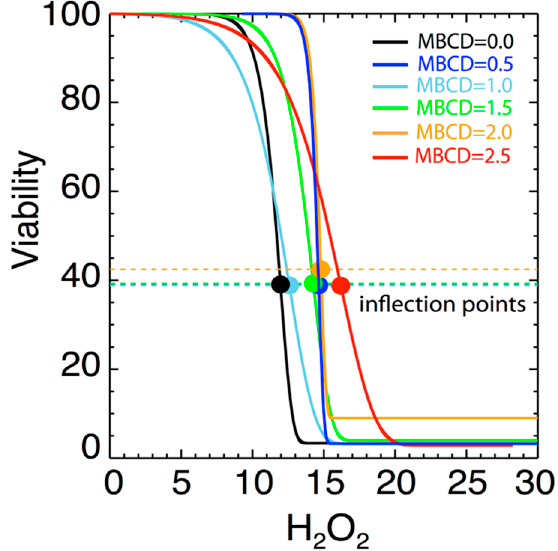
Figure 8. (Left) Diagrams of the modified p -value and reduced chi-square characterizing the linear fitting of the parameters α (a) , β (b) , γ (c) , and δ (d) , with MßCD plotted, as a function of the multiplication factor (M.F.). We identify the M.F. value, for which the corresponding p -value and reduced chi-square are optimized. The goodness of fit is shown using both the modified p -value and reduced chi-square. (Right) Here, the goodness of fit is shown using the unified measure as given by Equation (9) while it is depicted as a function of the signal-to-noise ratio of the slope b/ δ b , characterizing the linear fitting of the parameters with MßCD; (note: Both the ratio b/ δ b and the goodness of fitting are plotted as functions of the multiplication factor (M.F.)). The cases of the parameter α and γ have the optimal values of the p -value and reduced chi-square for │ b/ δ b │ < 1, so that the hypothesis of being dependent on MßCD is rejected. On the other hand, the cases of the parameter β and δ have the optimal values of the p -value and reduced chi-square for │ b/ δ b │ >> 1, thus, the hypothesis of MßCD dependence is accepted.